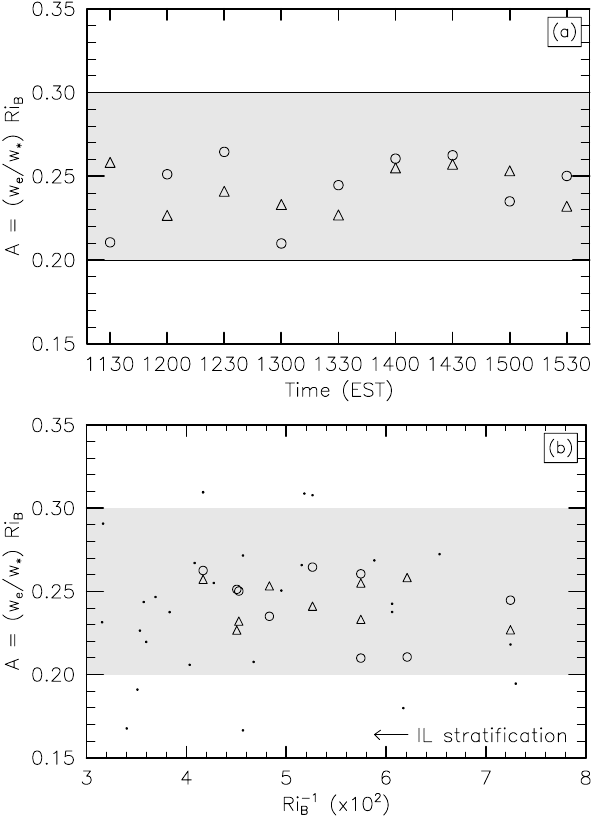
Fig. 9. (a) Dimensionless parameter A = (w e /w ∗ )Ri B for the dif- ferent times displayed in Table 1, with w e computed by two meth- ods: from the LES (using its definition d t z i ) ( 4 ); from the first- (cid:1) ( ◦ ). (b) same as (a) except that order model with F i = ϕ d (cid:0) z ∗ i (w e /w ∗ ) Ri B is now plotted as a function of Ri − 1 . Convection B tank measurements of Deardorff et al. (1980) are included for com- parison ( · ). The filled area represents A in the range 0.2–0.3.